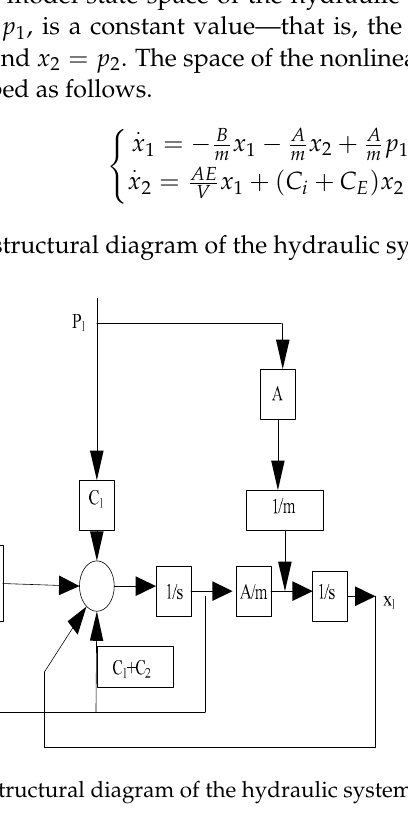
Figure 4. Structural diagram of the hydraulic system.